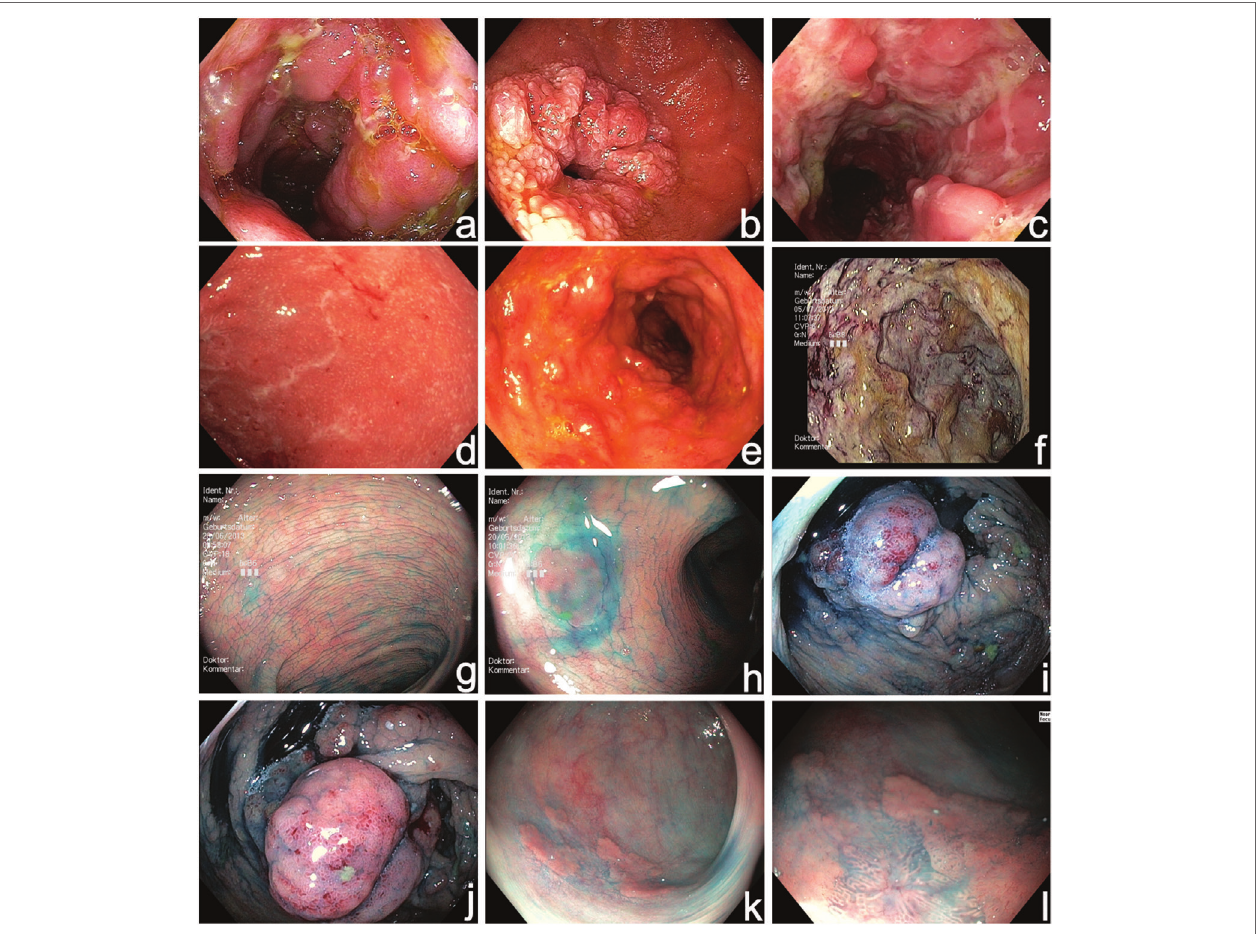
FiGURe 1 | High-resolution video endoscopy used for initial diagnosis of Inflammatory bowel disease (IBD) (a–f) and in combination with chromoendoscopy (diluted solution of indigocarmine 0.1%) during surveillance colonoscopy (g–l) . (a) Acute Crohn’s disease (CD) in the terminal ileum, (b) Crohn’s stenosis in the duodenum, (c) segmental fissural ulcerations in the left colon SES-CD 32, (d) mild active UC UCEIS 3, (e) moderate active UC UCEIS 5, (f) severe UC UCEIS 8, (g) normal chromoendoscopy with uniformly distributed contrast dye, (h) identification of a small flat lesion (hyperplastic polyp) with chromoendoscopy, (i,j) chromoendoscopy-guided evaluation of pseudopolyps during surveillance colonoscopy, (k,l) identification of an inhomogeneous flat polypoid area, and (l) with near focus mucosal irregularities are visible indicating high grade intraepithelial neoplasia. SES-CD, simplified endoscopy score for Crohn’s disease; UCEIS, ulcerative colitis endoscopic index of